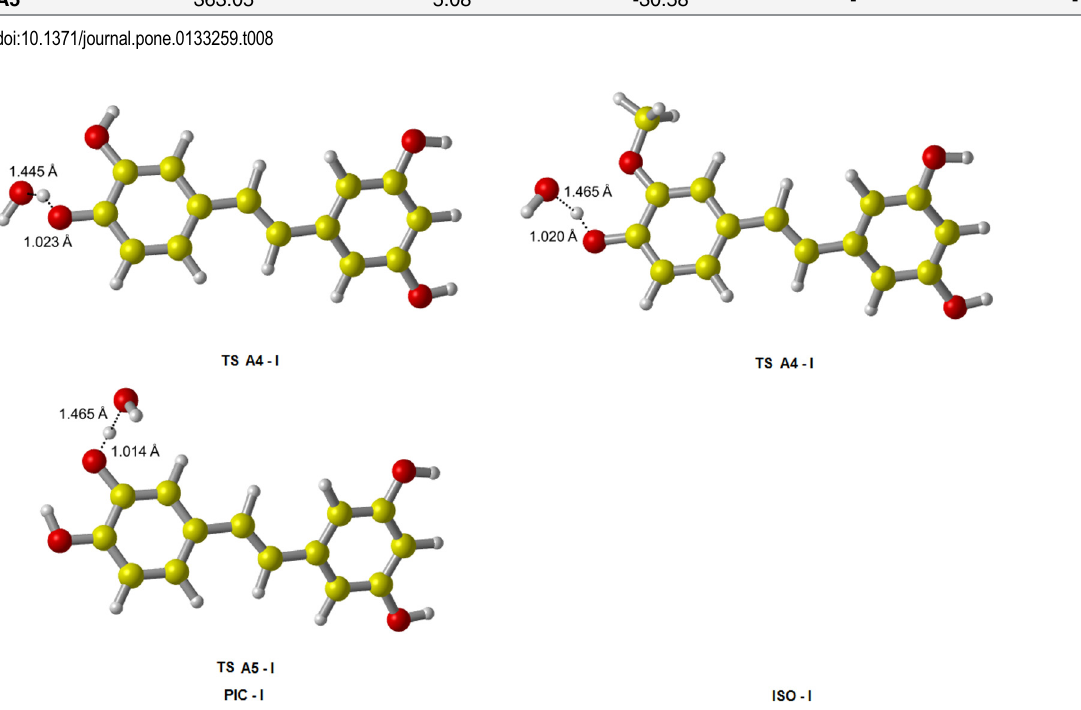
Fig 12. The transition state geometries of PIC-I and ISO-I from ABS reactions initiated by (cid:129) OH. The elongations of the breaking bonds are smaller than those of the forming bonds, indicating that these TS are all reactant-like, i.e. these reactions are all exothermic in light of the Hammond ’ s postulate. These agree with our calculated results in Table